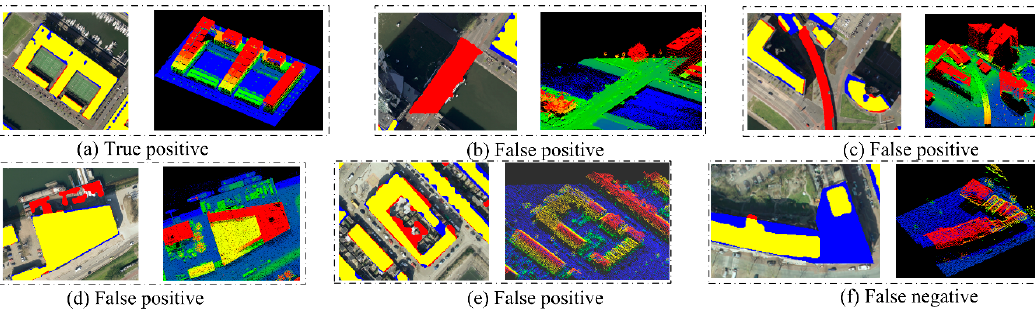
Figure 10. Four examples of the change detection results for Rotterdam data. Quantitative results: Our building extraction results are evaluated at the pixel level. The method achieves precision of 91.94%, recall of 82.64% and F 1 -score of 87.04%. Although we do not have comparative methods for building extraction, a glimpse at [11] can still give us hints on the performance of our method. The ISPRS benchmark on urban object detection [11] reports that the high-ranking building extraction methods can achieve F 1 -score of 89.8% and 88.9%, depending on the data quality and applied method. Additionally, multispectral features are also available to them. Without multispectral features, we achieve F 1 -score of 87.04% with merely geometric features, which is relatively satisfactory. The change detection results are evaluated at the pixel level and object level as shown in Tables 3, and 4, respectively. In Table 3, the recalls for heightened buildings and demolished buildings from our method are both above 85%, indicating that most of the two types of changes can be detected successfully. The precision of the heightened buildings is 69.26%, which is much lower than the 95.20% of the demolished buildings. As explained before, the demolished buildings are determined on the ALS data which are more precise, while most of the heightened buildings are determined on the DIM data, which are noisier. Table 3. Pixel-based change detection results of Rotterdam data (%). Method